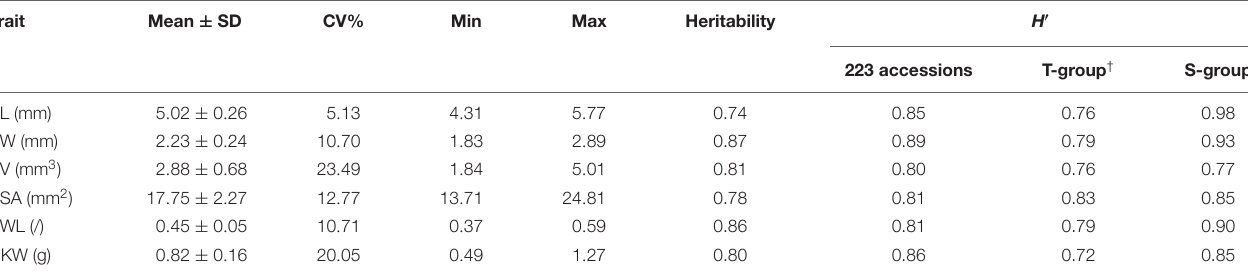
TABLE 2 | Descriptive analysis, coefficient of variation, heritability, and Shannon–Weaver diversity index ( H (cid:48) ) of six kernel traits based on BLUP values among the 223 Aegilops tauschii . Trait